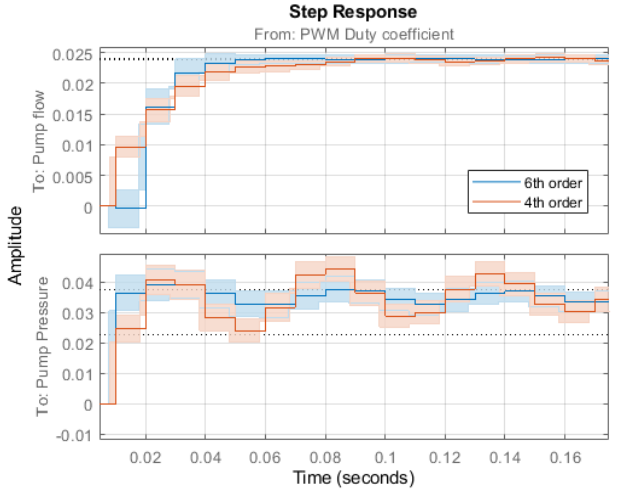
Figure 12. Comparison of magnitude frequency of 6th order model.